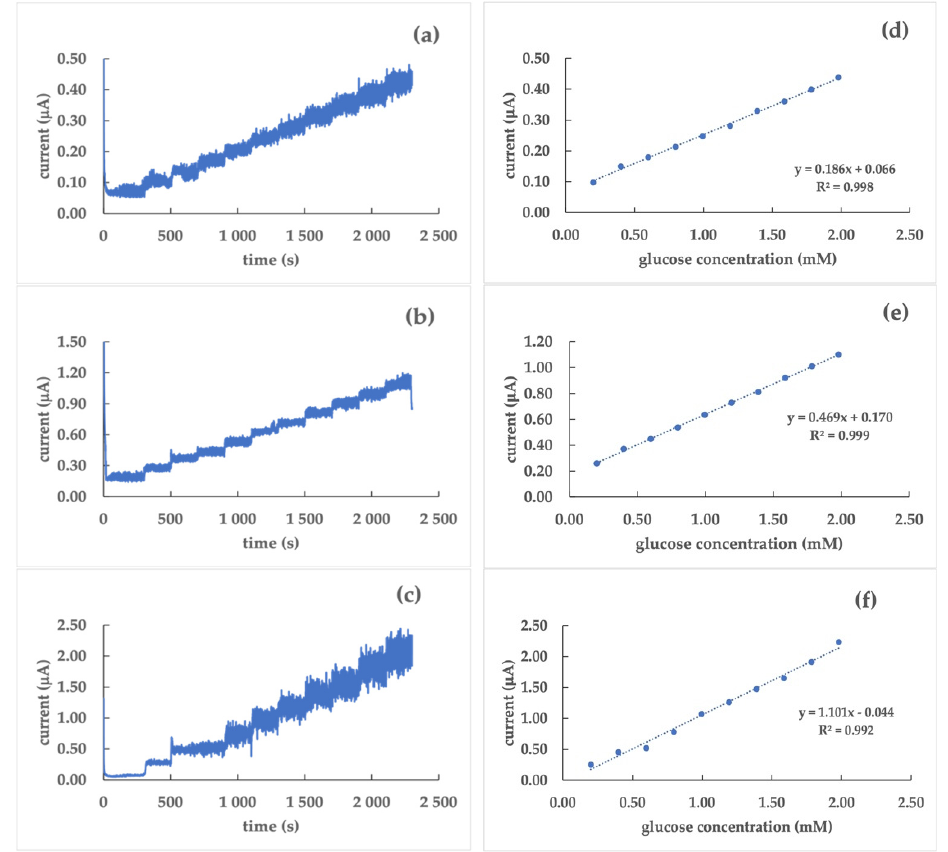
Figure 4. Current/time responses ( a − c ) and corresponding calibration curves ( d − f ) of Pt/poly(dTT − bT)/GOx ( a , d ), GC/poly(dTT − bT)/GOx ( b , e ), and Au/poly(dTT − bT)/GOx ( c , f ) biosensors in a phosphate buffer (0.1 M, pH 7.0) at a glucose concentration range of 0.2 ÷ 2.0 mM; working potential: 0.40 V vs.